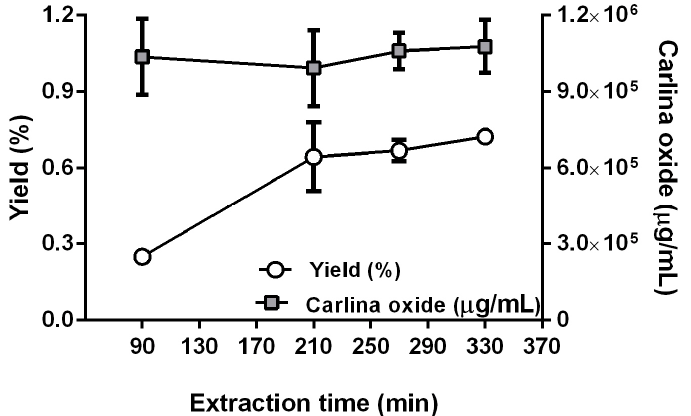
Figure 5. Influence of the extraction time on essential oil (EO) yield (%) and carlina oxide content ( µ g/mL) for the extraction runs performed after the fractional factorial design (FFD) (Section S1 of the Supplementary Materials). Results of different extraction time points for both responses were matched with ANOVA and further analyzed using Tukey’s HSD test for significant differences. Different letters show significant differences (Tukey’s HSD test, p < 0.05).